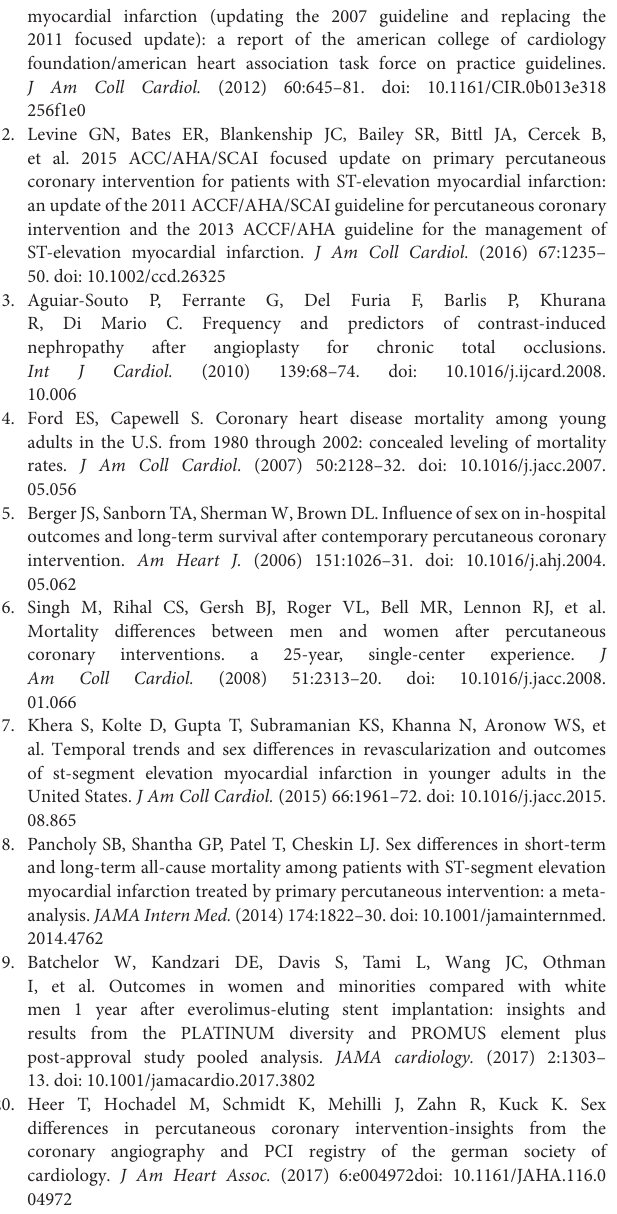
Supplementary Figure 1 | The flow of participants through the trial. Supplementary Table 1 | Clinical characteristics of patients with CAD in different time